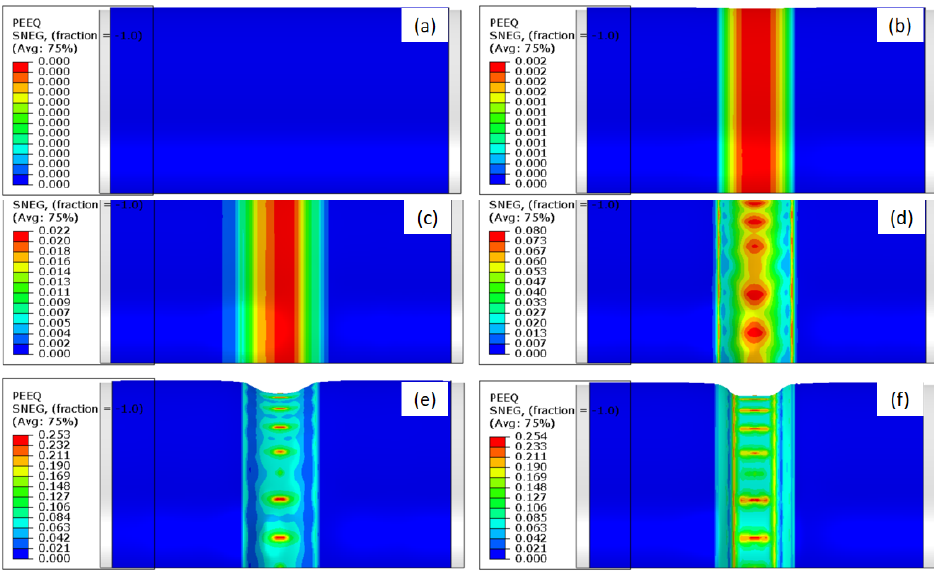
Figure 12. The variation of the equivalent plastic strain distribution under different external pressure values: ( a ) 0 MPa, ( b ) 7 MPa, ( c ) 10 MPa, ( d ) 12 MPa, ( e ) 20 MPa, ( f ) 100 MPa.